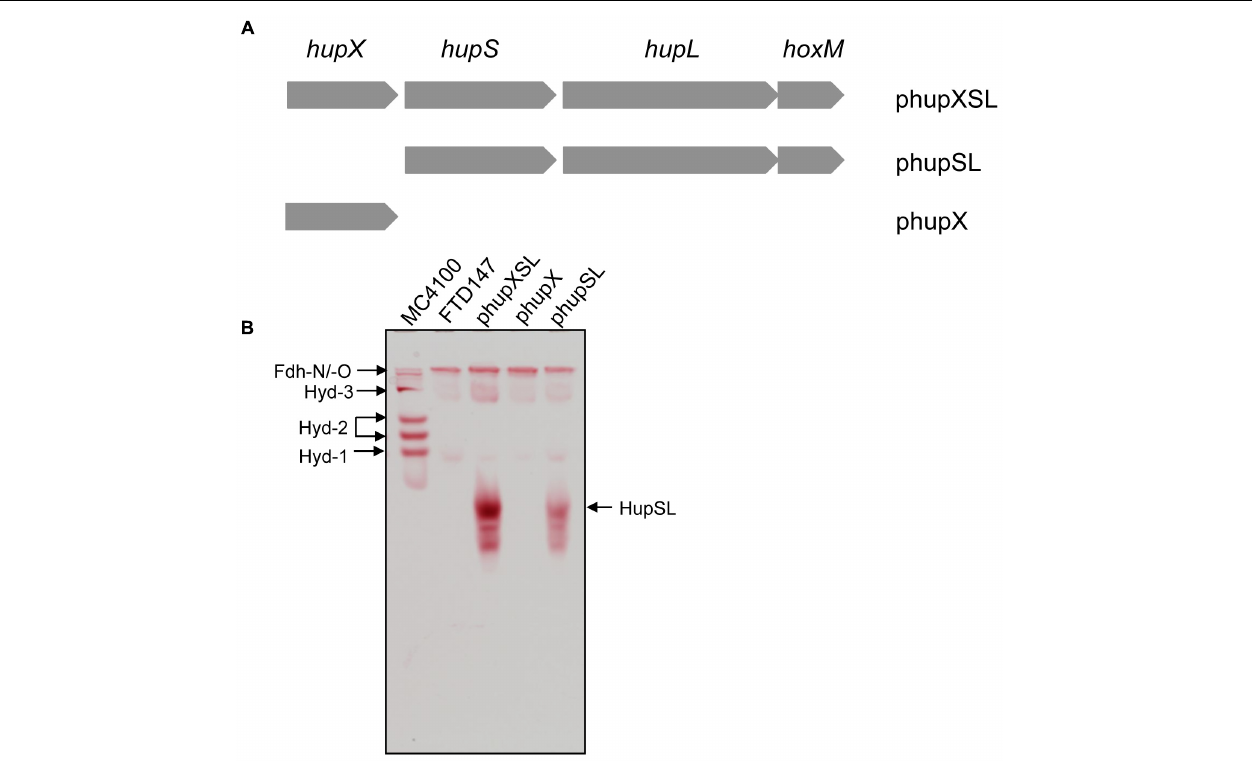
FIGURE 1 | HupX is not required for heterologous HupSL activity. (A) Schematic representation of the plasmids used in this study is shown. The plasmid inserts are not drawn to scale but the complete hupXSLhoxM region encompasses 4216 bp (Hartwig et al., 2015b). (B) An in-gel activity stain for hydrogen-oxidizing activity is shown. Crude extracts (70 µ g of protein; 30 µ g in the case of wild type MC4100) derived from FTD147 ( (cid:49) hyaB (cid:49) hybC (cid:49) hycE ) carrying the indicated plasmids were applied to a native polyacrylamide gel (7.5% w/v polyacrylamide). The migration positions of HupSL and the E. coli hydrogenases are indicated. The formate dehydrogenases Fdh-N and Fdh-O (Fdh-N/O) have a weak hydrogen-oxidizing activity (Soboh et al., 2011), which is also indicated and was used as an internal loading control for the